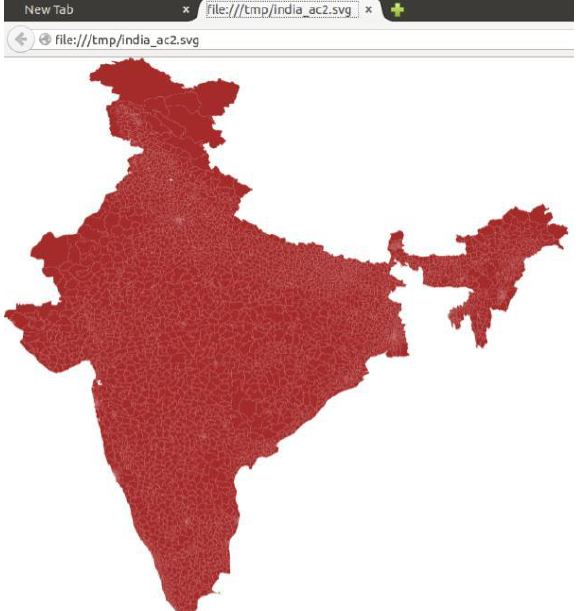
Figure 4. Rendered GMZ in Firefox using an